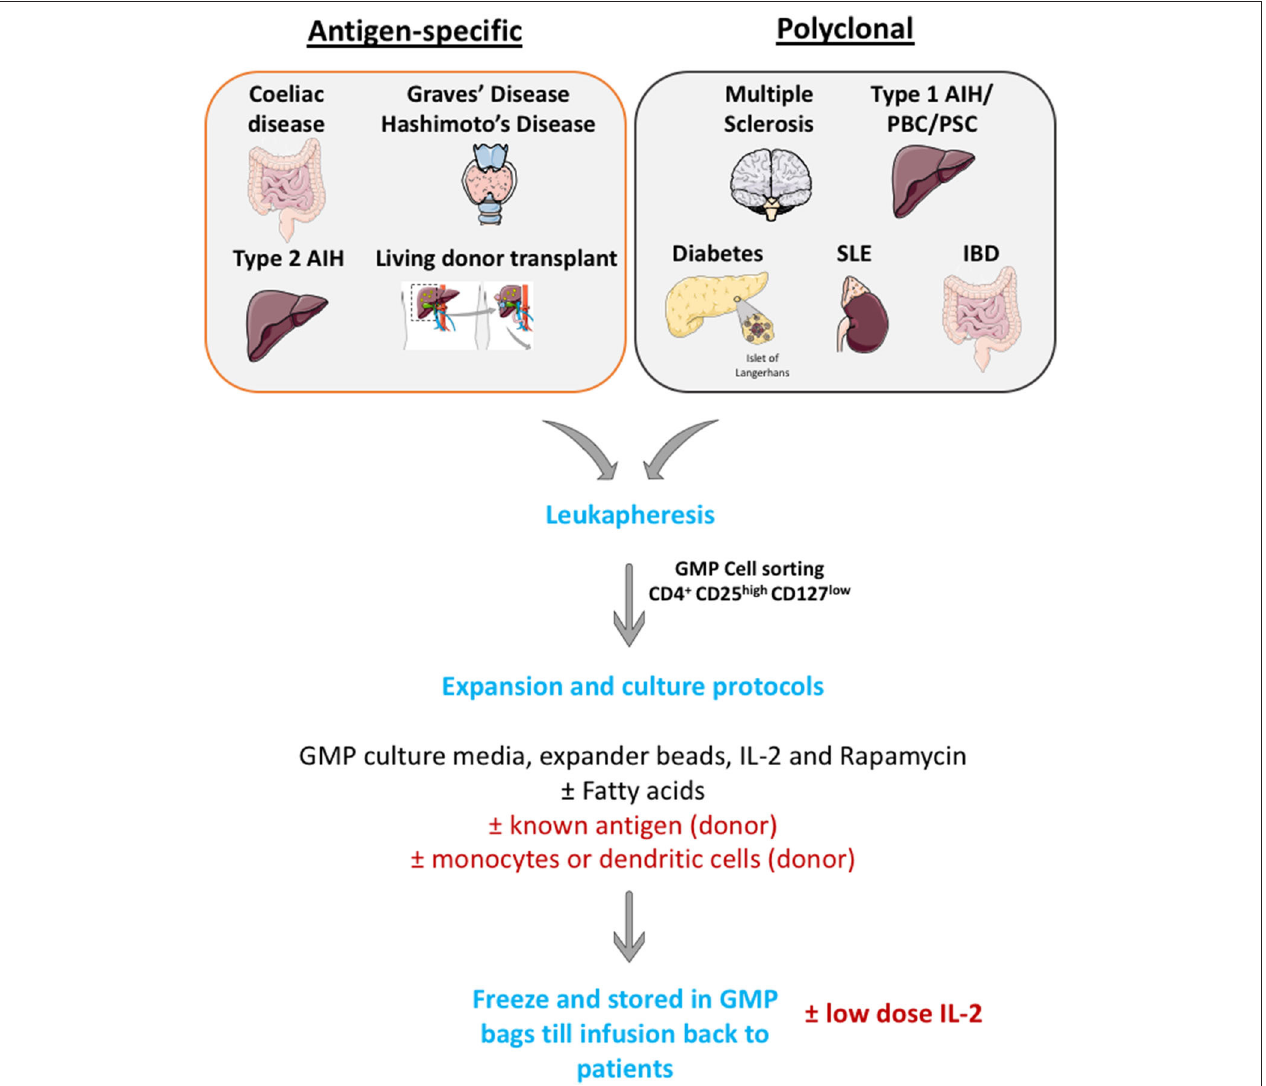
FIGURE 4 | Schematic illustration of large scale GMP Treg production. Leukapharesis procedures are performed to those patients with either autoimmune diseases or those who will undergo transplantations. GMP Treg will be cell sorted using surface markers to obtain highly pure CD4 + CD25 high CD127 low cells population. Then, cells will be expanded in GMP culture media with GMP-grade IL-2 cytokines, GMP-grade rapamycin (to prevent effector T cells outgrowth) and GMP-grade CD3, CD28 Treg expander beads (with or without known antigen). These cells will then undergo quality assessment process and will be frozen until infusion back to patients.